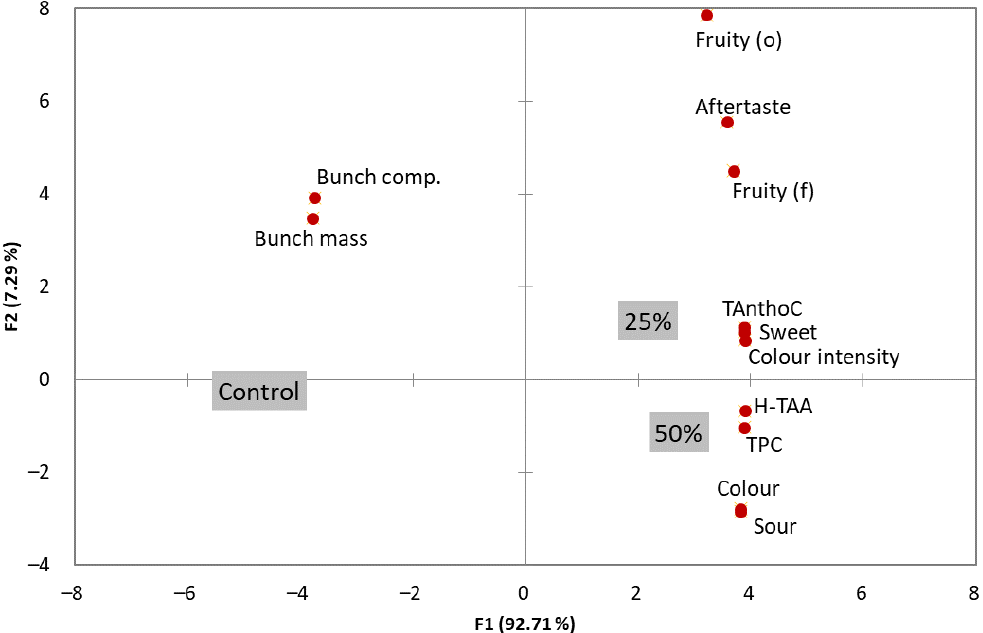
Figure 3. Principal component analysis (PCA) scores plot showing the relationship among parameters related to bunch architecture, physicochemical and functional properties of wine grape, as well as sensory parameters of wine. (o): odor; (f): flavor; TAnthoC: total anthocyanins content; H–TAA: hydrophilic total antioxidant activity; TPC: total phenolics content; bunch comp.: bunch compact- ness.